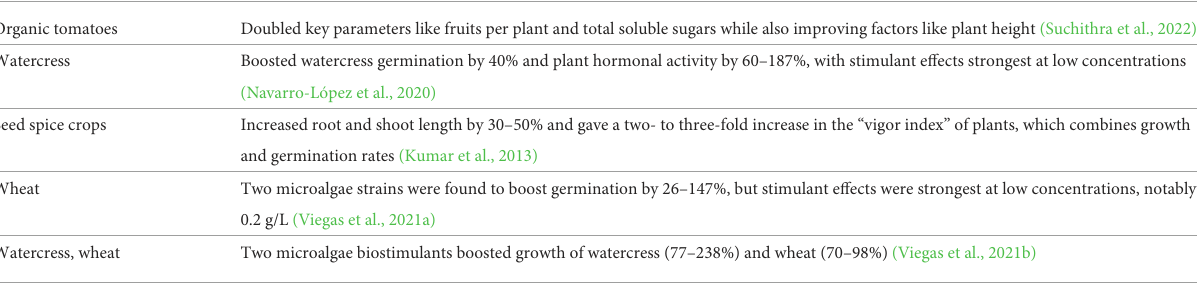
TABLE 5 Efficacy of microalgae-based biostimulants on crops. Crops Study findings Organic tomatoes